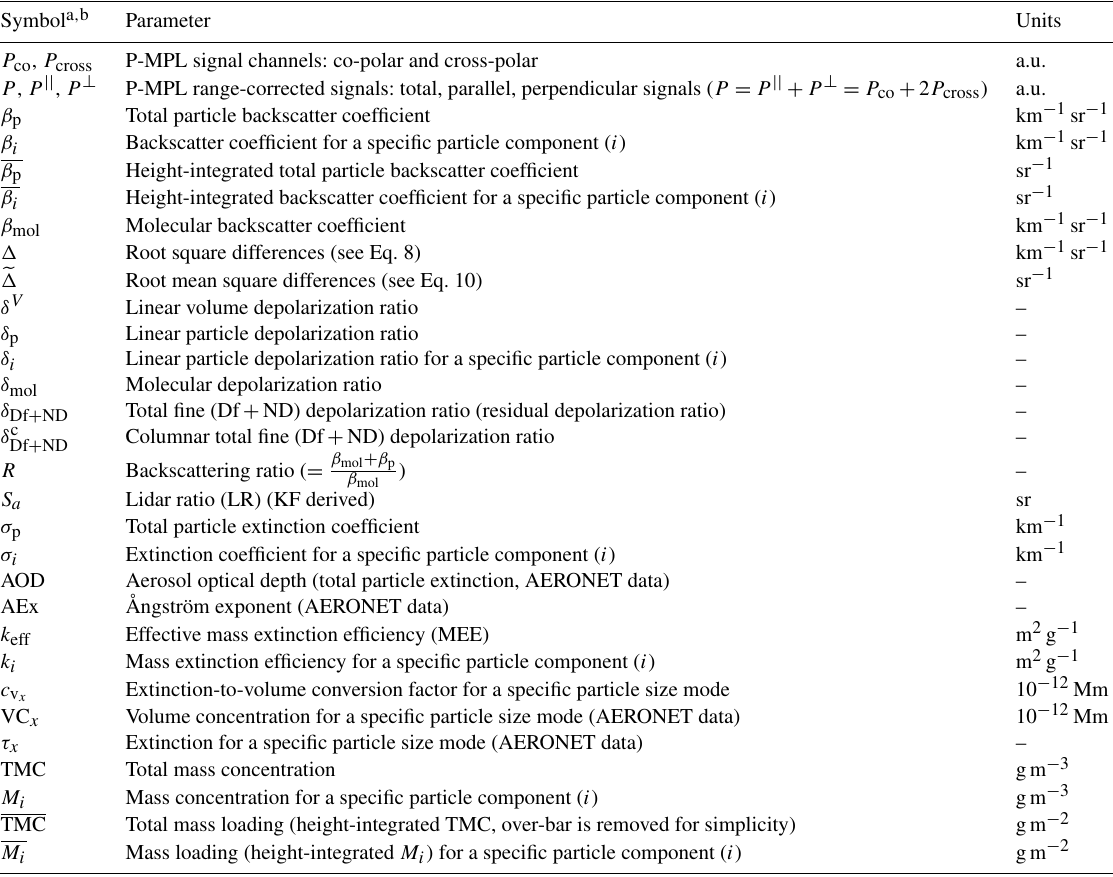
Table A1. List of